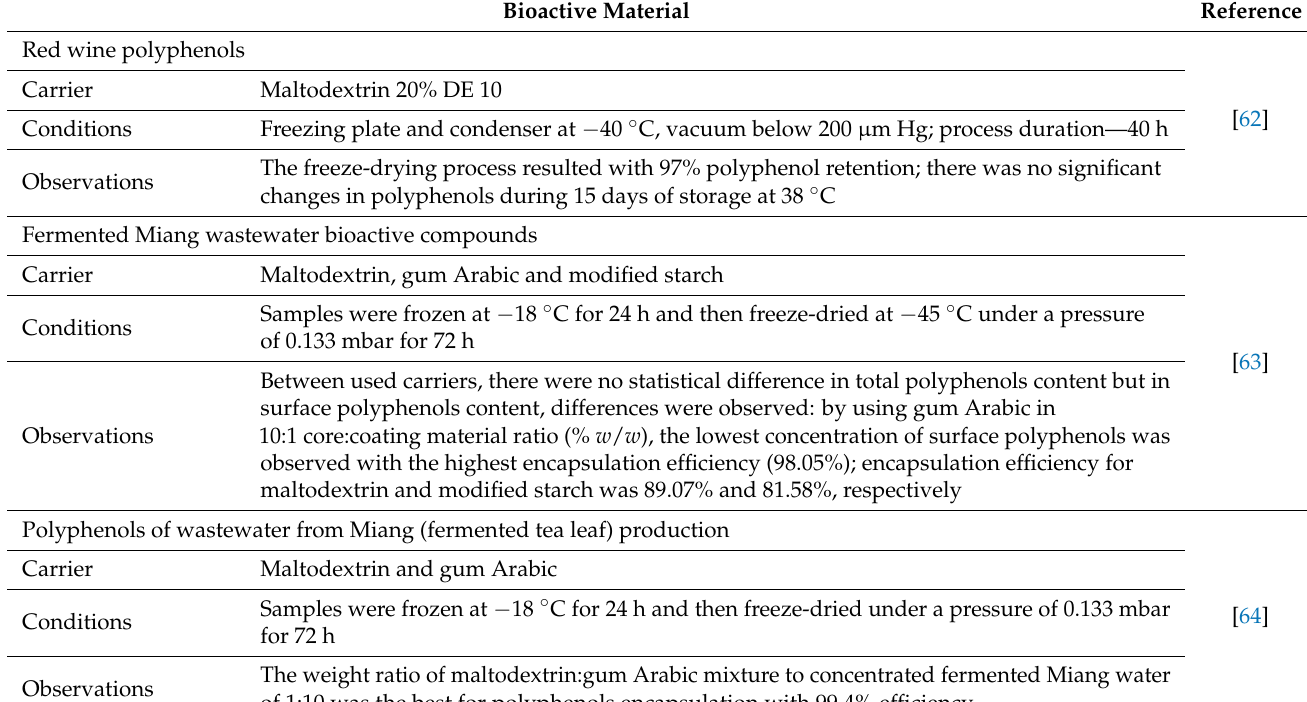
Table 2. Studies of freeze-drying application for encapsulation of polyphenols from different sources. Bioactive